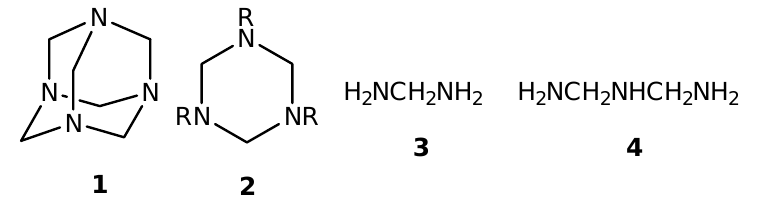
Figure 1. Structures of hexamine ( 1 ), 1,3,5-hexahydrotriazine ( 2 ), methylenediamine ( 3 ) and dimethylenetriamine ( 4